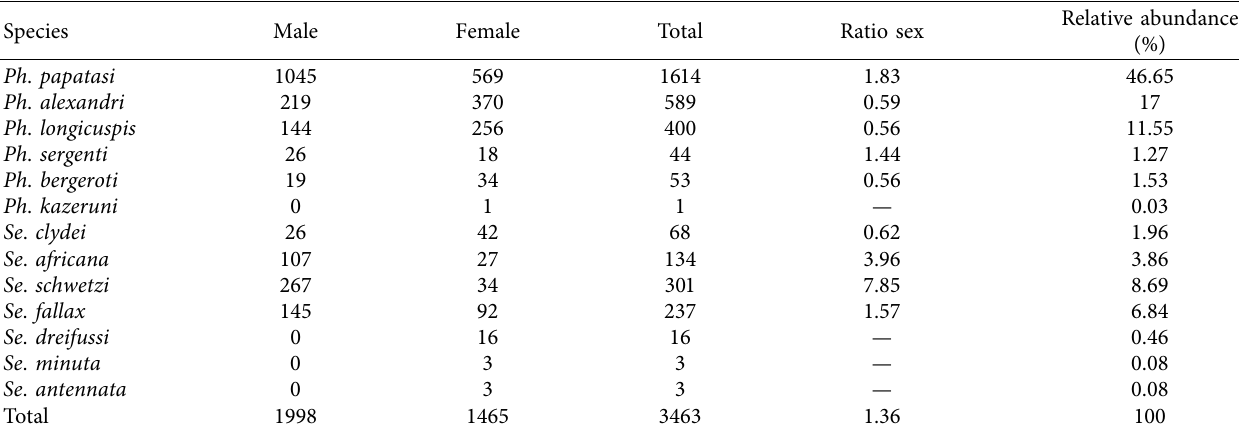
Table 2: Number of specimens and relative abundance of sand fy species collected in the ten villages of Zagora Province. Species